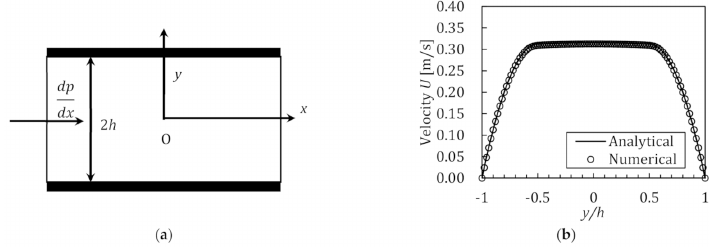
Figure 6. Validation on Non-Newtonian fluid flow through a 2D slit. ( a ) Schematic of the 2D parallel plates. ( b ) Velocity profiles by numerical simulations and analytical